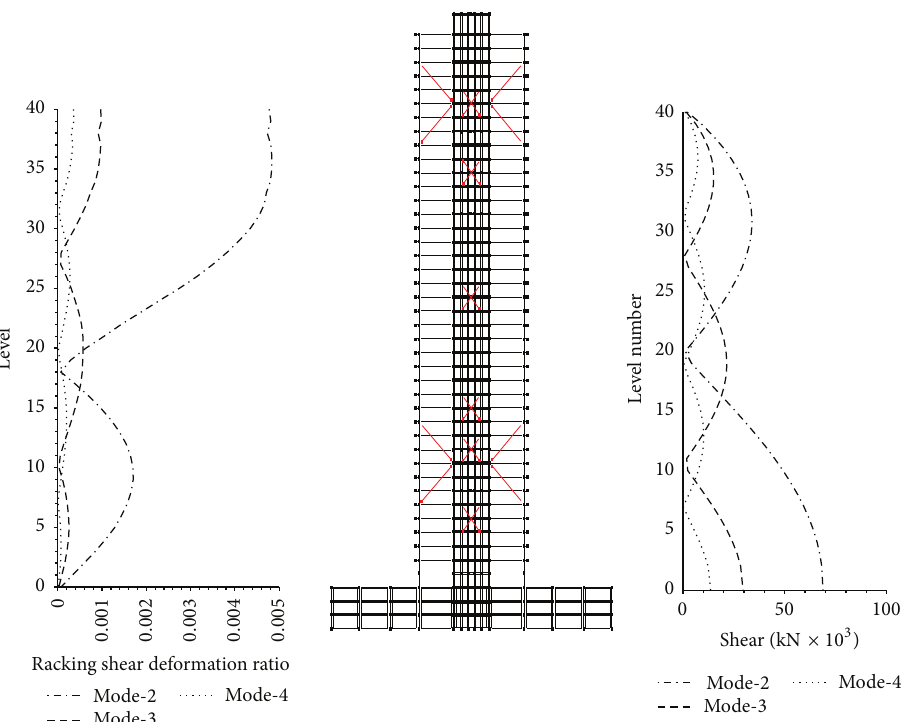
Figure 9: Arrangement of the exterior BRBs at locations of maximum DBE elastic racking shear deformation in 2nd and 3rd mode and interior BRBs at locations of maximum DBE elastic shear demands in 2nd and 3rd mode (Option-3).